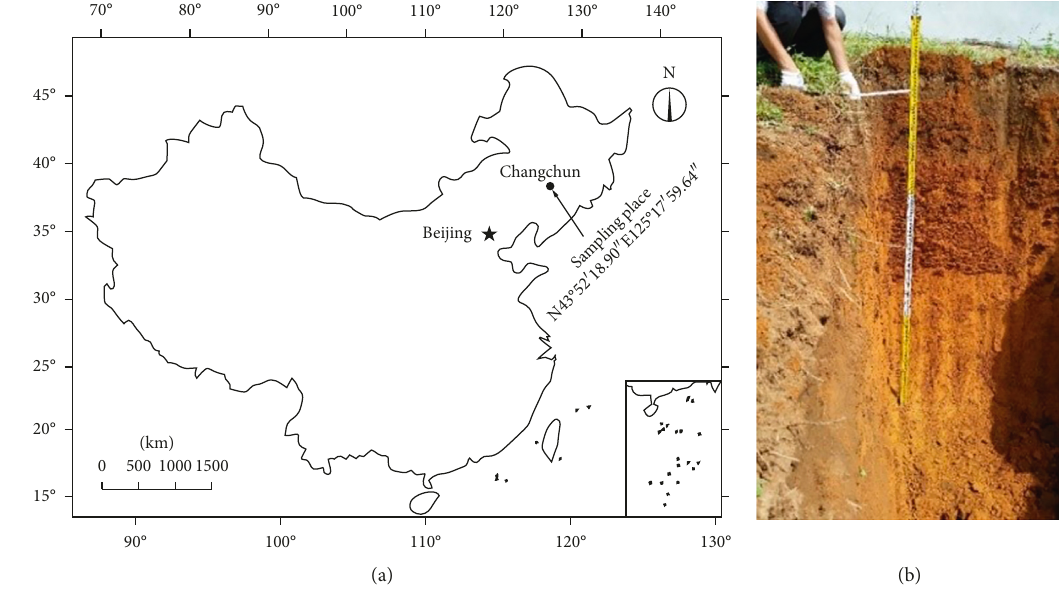
Figure 1: Illustration of the location of the sampling point. Table 1: Basic physical properties of the soil sample. Moisture